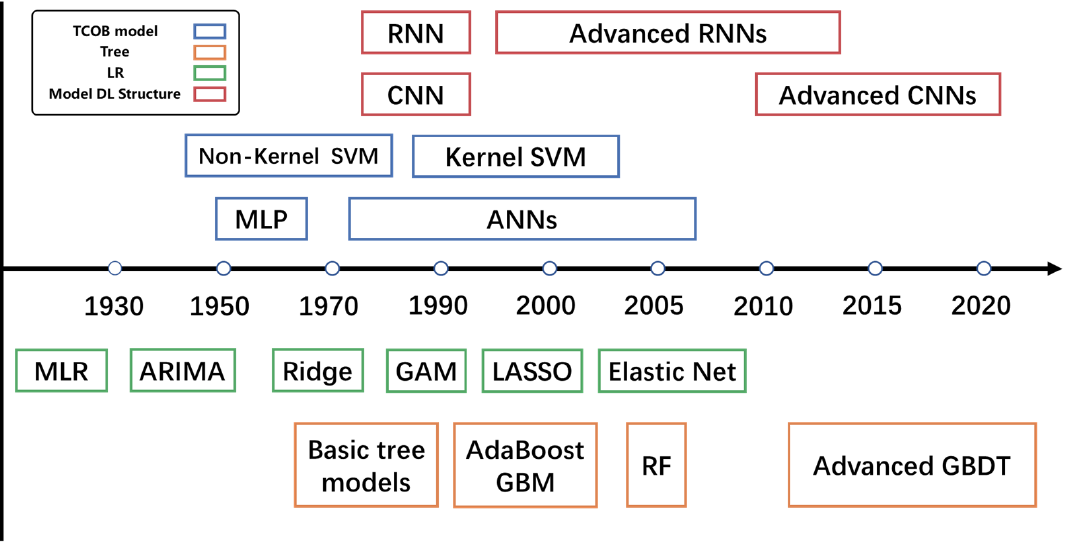
Figure 1. Development timeline of ML models.